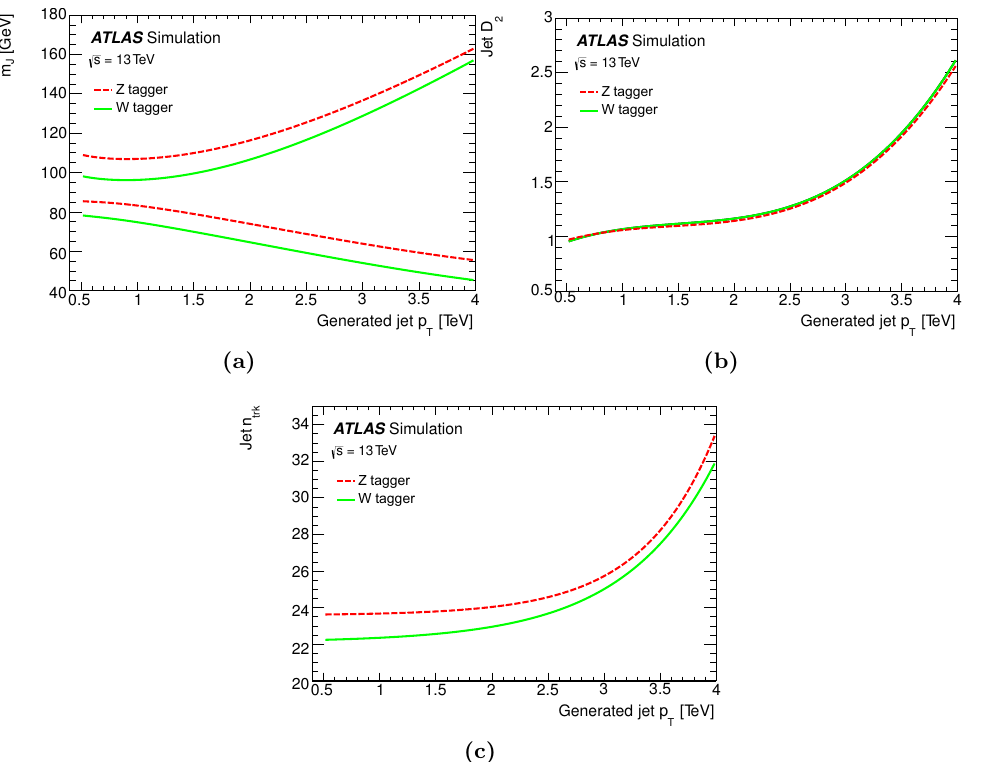
Figure 2 . (a) Jet mass window, (b) D selection and (c) n selection of the W and Z taggers as 2 trk a function of jet p . Jets selected in the analysis are required to have jet masses inside the jet mass T window and D and n values below the shown values. The tagger is only valid for jets with a p 2 trk between 0.5 TeV and 4.0 TeV and with j (cid:17) jet j < 2 :